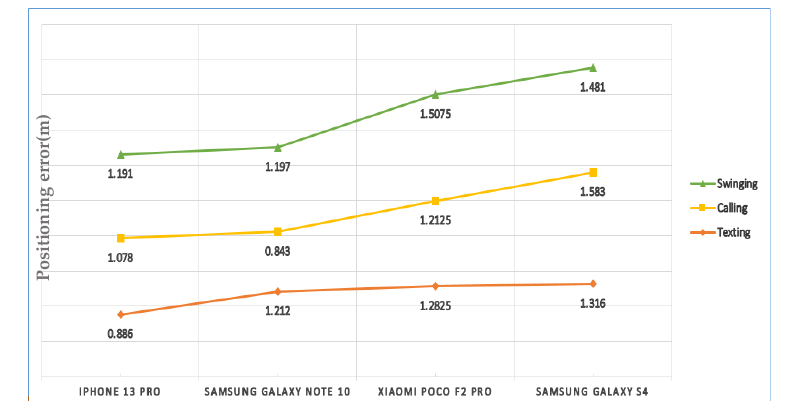
Figure 26. Comparison of the average positioning errors of different smartphone models.